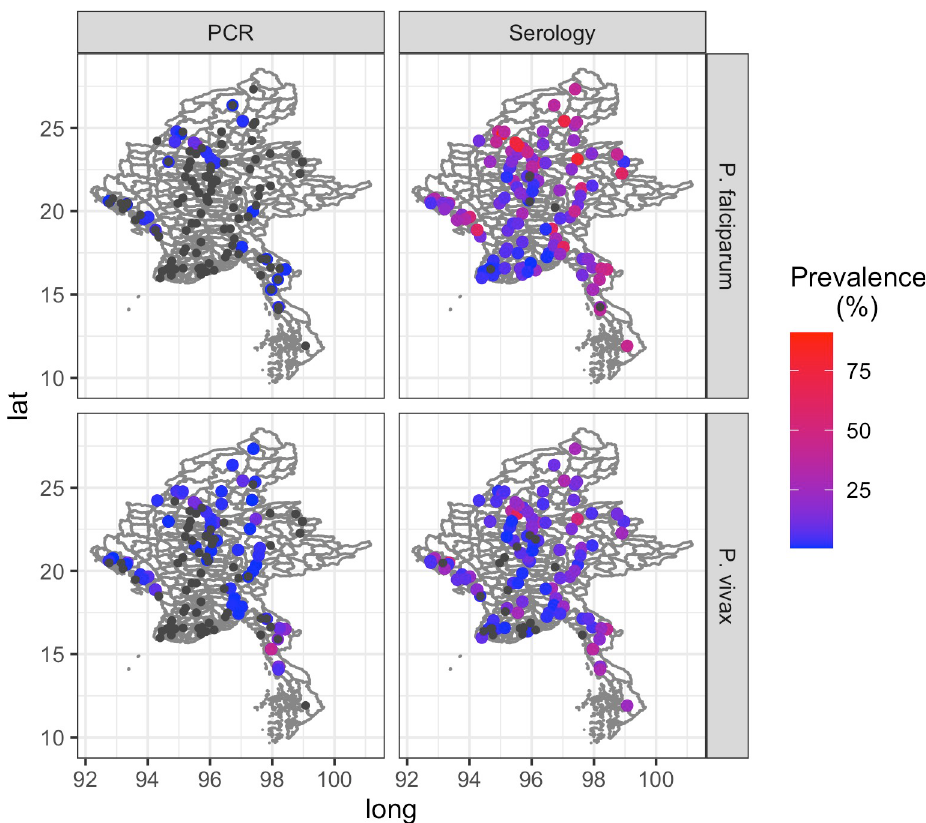
Fig 4. Maps showing prevalence (left column) and seroprevalence (right column) of P . falciparum (top row) and P . vivax (bottom row) in each sampled cluster. Each dot represents one cluster (one village) coloured according to level of prevalence or seroprevalence. Black dots indicate clusters where no positive PCR or serology cases were